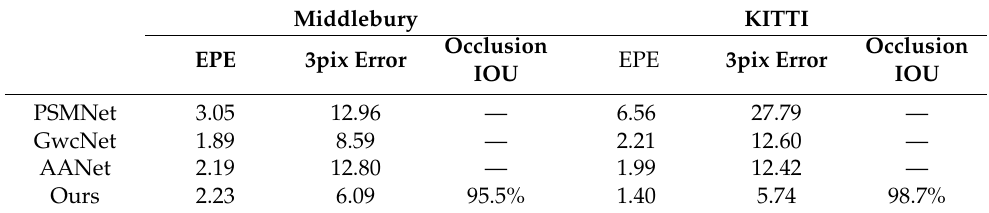
Table 5. Generalization performance